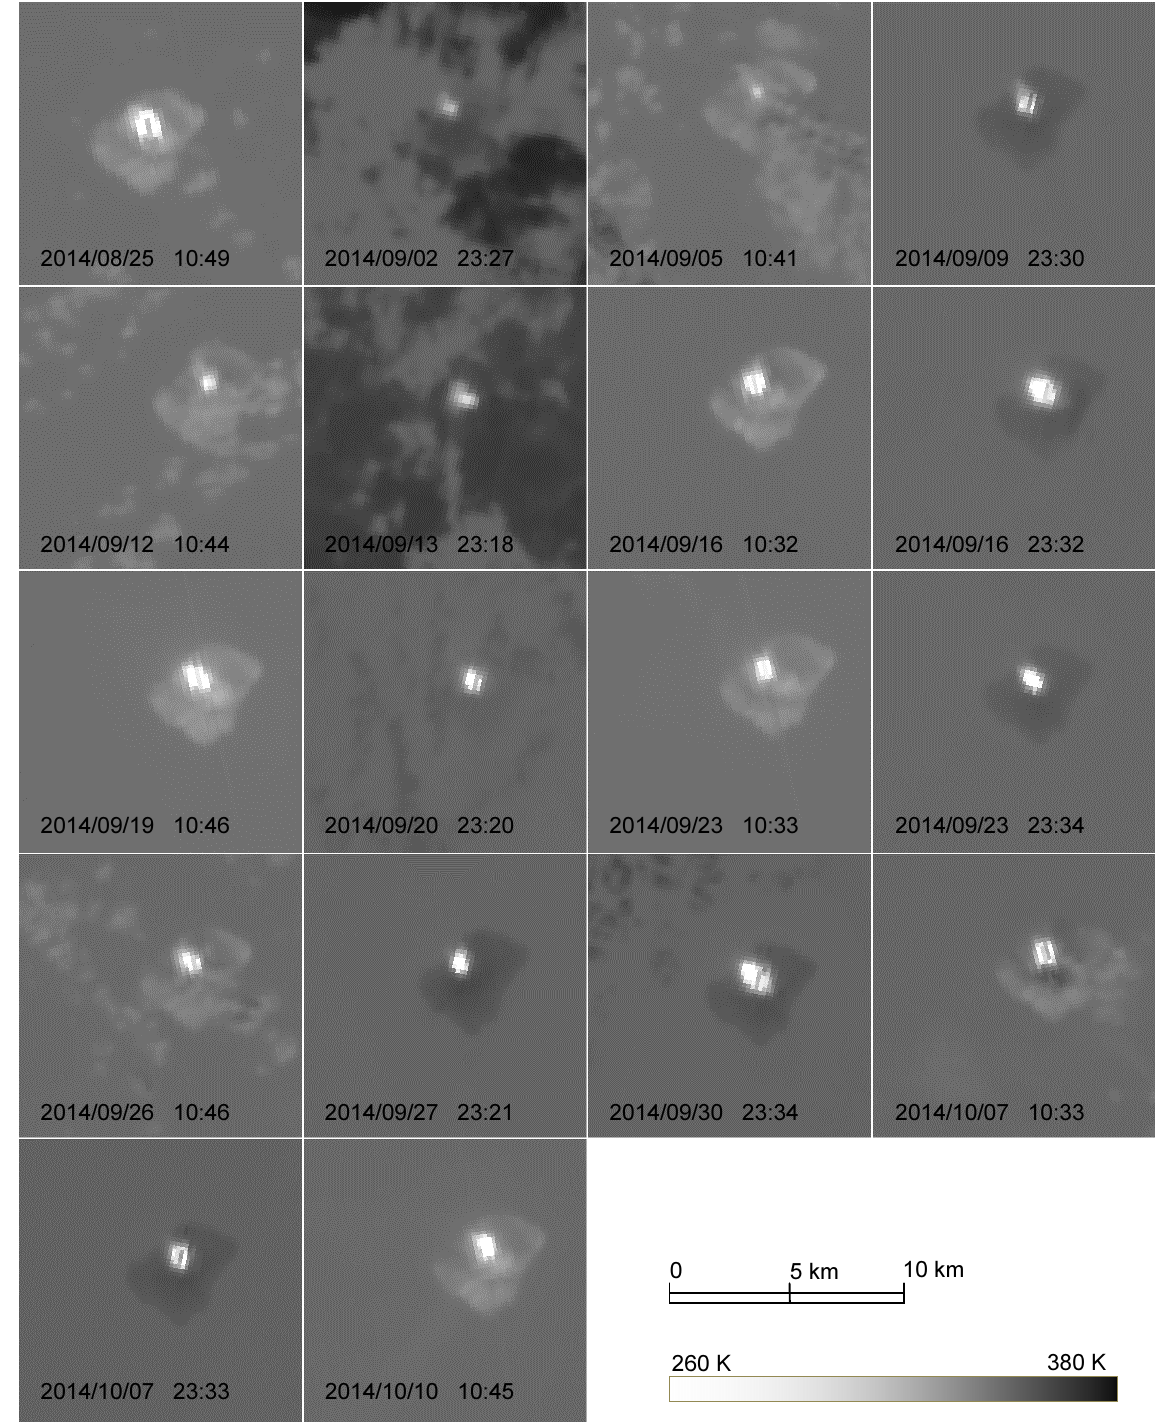
Fig. 3. Brightness temperature (range 260–380 K) from TET-1 data; time is given in UTC. Land is darker (cooler) on night images, sea has almost constant temperature, and clouds appear very cool as well. The brightest (hottest) areas correspond to lava flow, which is on the peak divided into two flows (see also fig.